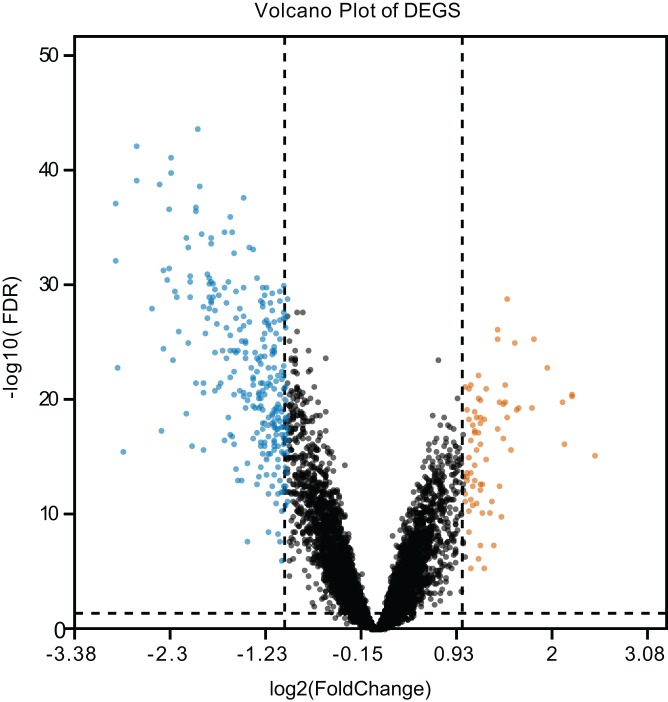
Volcano plot of the DEGs.The vermilion and blue dots represent DEGs filtered based on the cut-off values of |log2FoldChange| > 1.0 and adjusted P-value (FDR) < 0.05, while the black dots represent genes that are not satisfied the cut-off values of differential expression. The horizon dotted line indicates the position of −log10 (FDR) = 0.05, and the vertical dotted lines indicate the positions of |log2FoldChange| = 1.0. Vermilion, upregulation; blue, downregulation. DEGs, differentially expressed genes; FDR, false discovery rate.